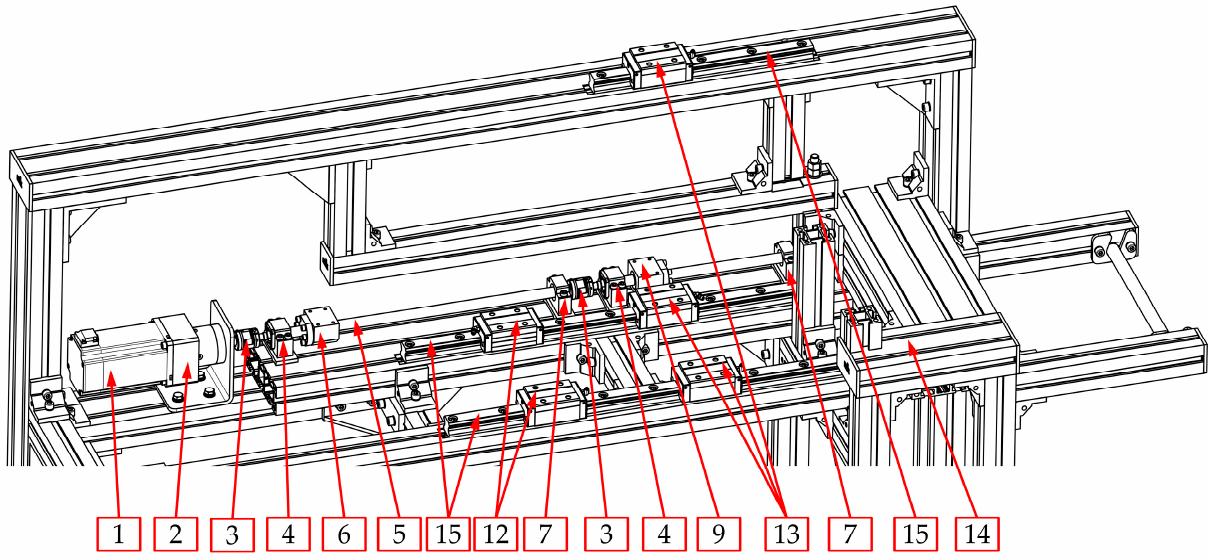
Figure 7. The main drive and guiding system of the automatic welding machine: 1—BLDC electric motor, 2—planetary gear, 3—jaw coupling with flexible insert, 4—angular bearing unit (fixing), 5—ball screw with pitch p 1 , 6—ball nut with pitch p 1 , 7—radial bearing unit (floating), 8—ball screw with pitch p 2 , 9—ball nut with pitch p 2 , 12—carriages of the guiding of the movable belt holder, 13—carriages of the guiding of the heating unit, 14—structural frame, 15—profiled rail.